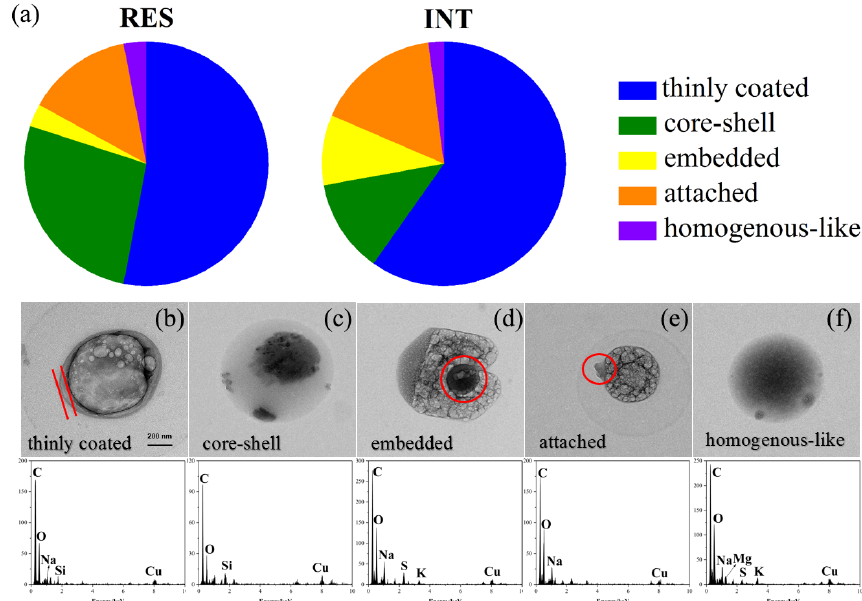
Figure 5. Number fractions of OM-containing particles with different mixing structures in the RES and INT (a) and typical TEM images and corresponding EDS spectra of OM: thinly coated (b) , core-shell (c) , embedded (d) , attached (e) , and homogenous-like (f) particles during cloud event nos. 2 and